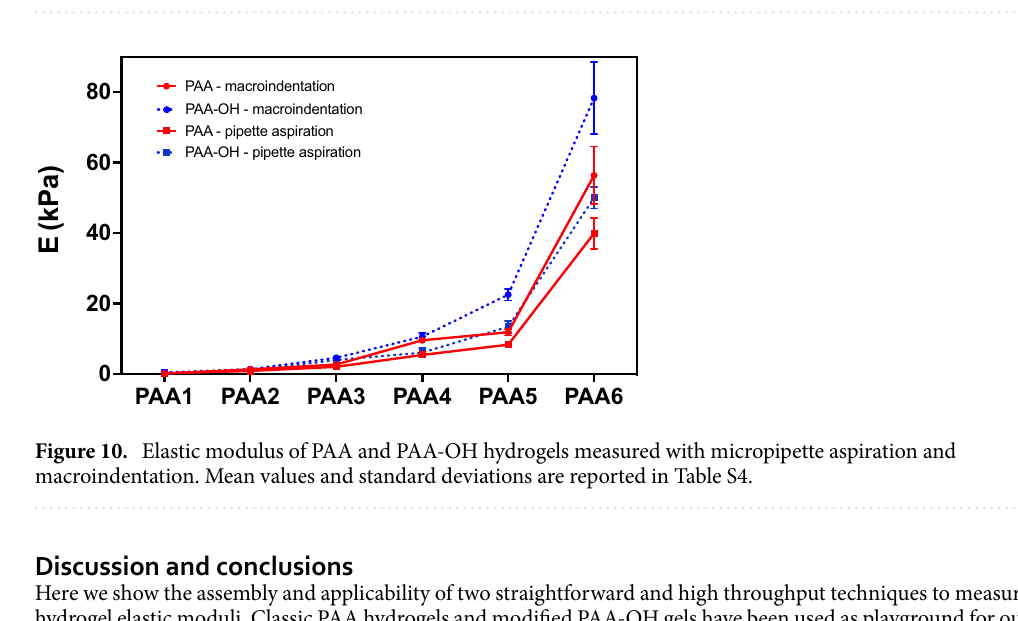
Figure 9. Scheme of PAA-OH hydrogels soft (left) and stiff (right).